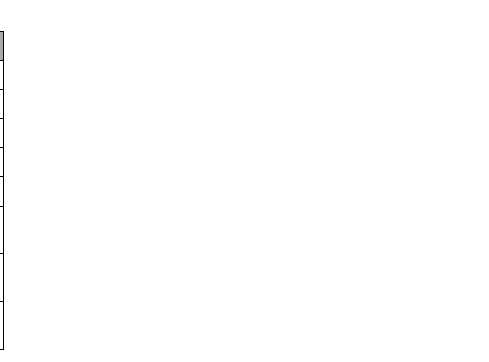
Table 4. PK-PD modeling of ex vivo cyadox after oral administration at a dose of 30 mg/kg.